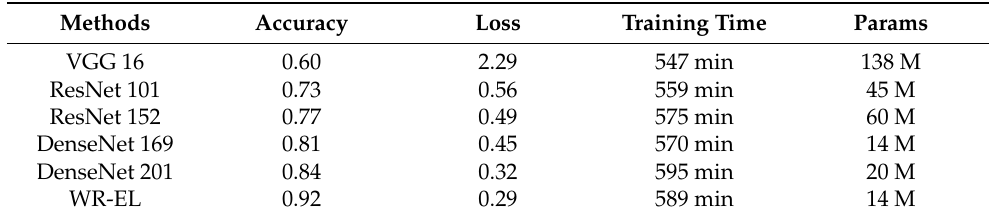
Table 2. Performance of the WR-EL model.